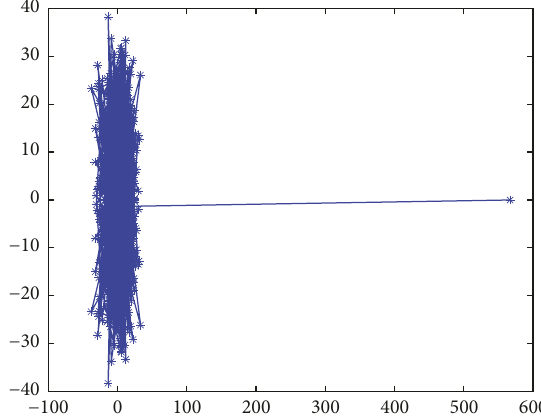
Figure 6: Frequency spectrum analysis of the